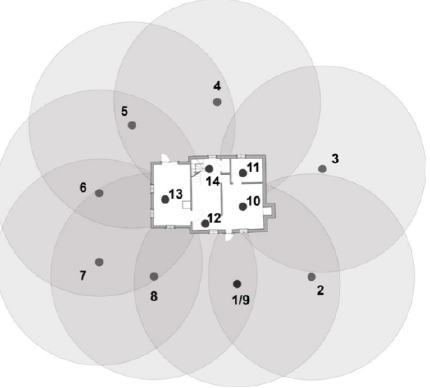
Figure 9. Thibault log cabin during the survey